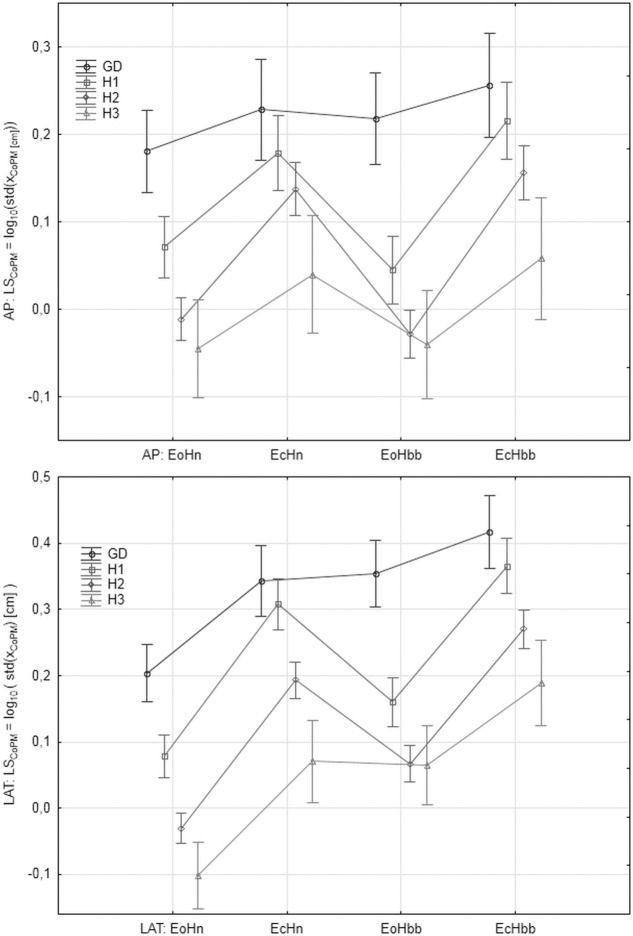
The mean values of LSCoPM = log10(SCoPM) in the subsequent patients and registration condition groups.SCoPM represents the variability of xCoPM signal measured as SCoPM = std (xCoPM). Upper: antero-posterior (AP), bottom: lateral (LAT) component of the signal.